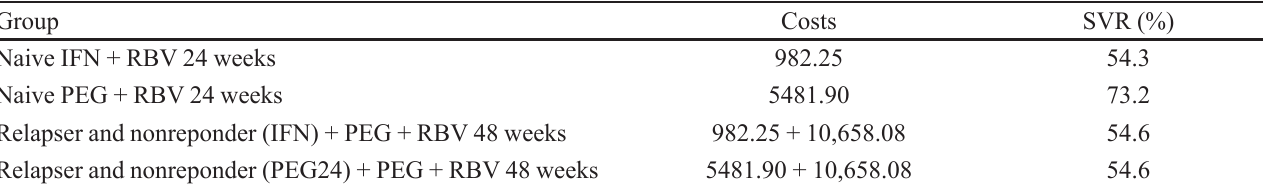
TABLE I - Costs (USD $) and effectiveness per course of treatment